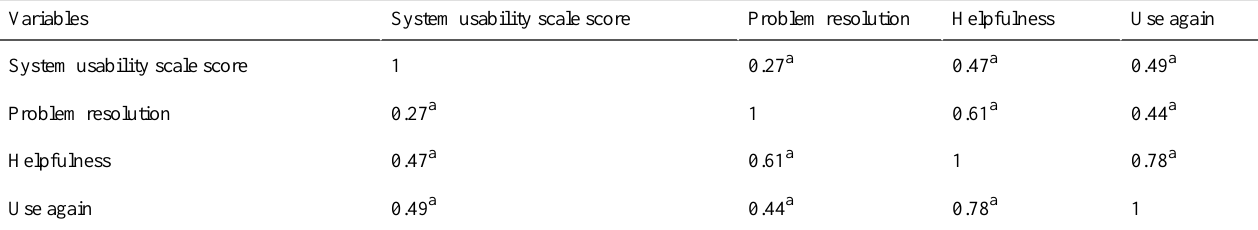
Table 5. Pearson Correlations for postintervention Manage Your Life Online and ELIZA ratings of system usability, problem resolution, helpfulness, and willingness to use Manage Your Life Online/ELIZA